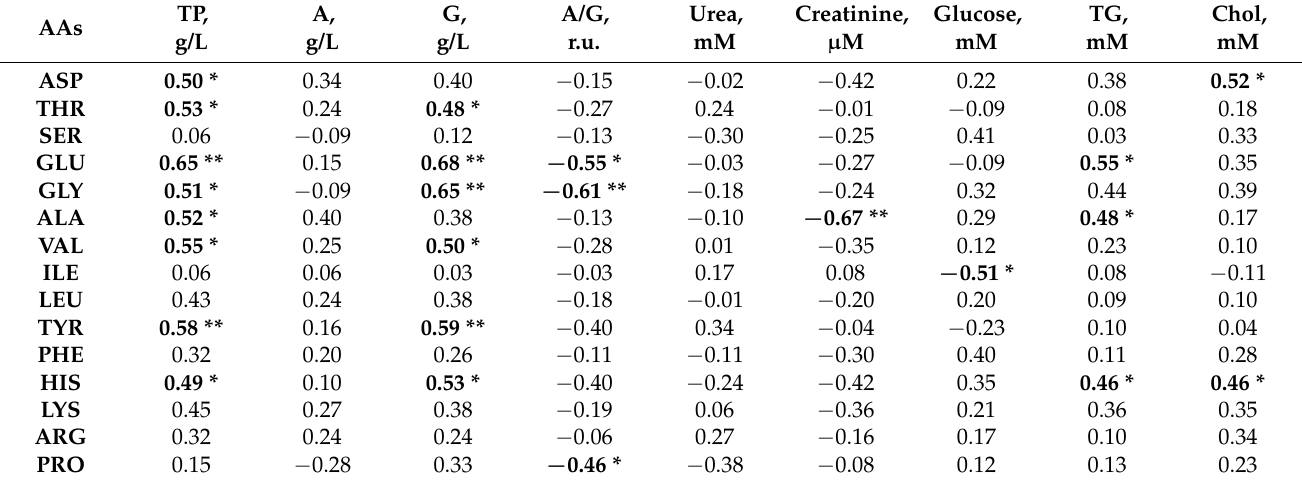
Table 6. The correlation coefficients between all obtained amino acids and the major